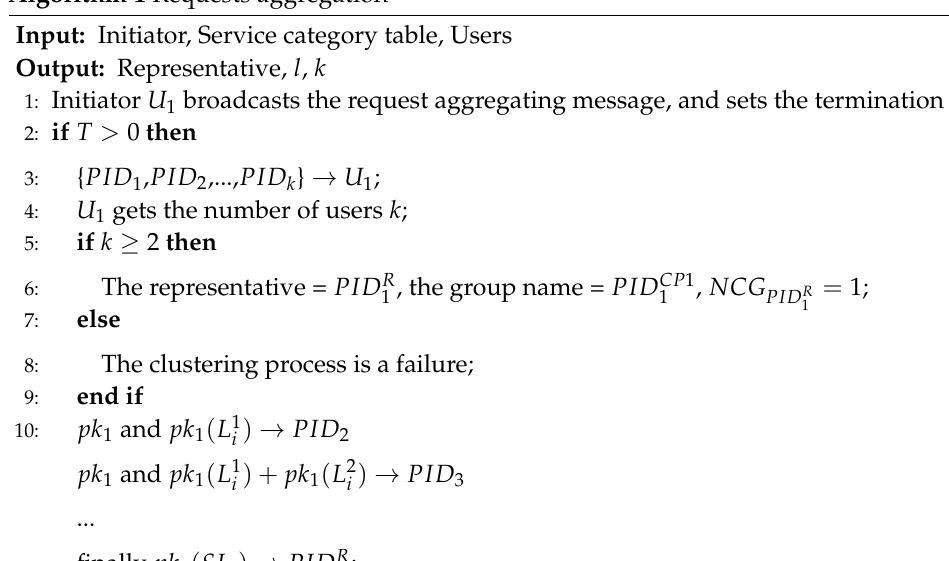
Algorithm 1 Requests